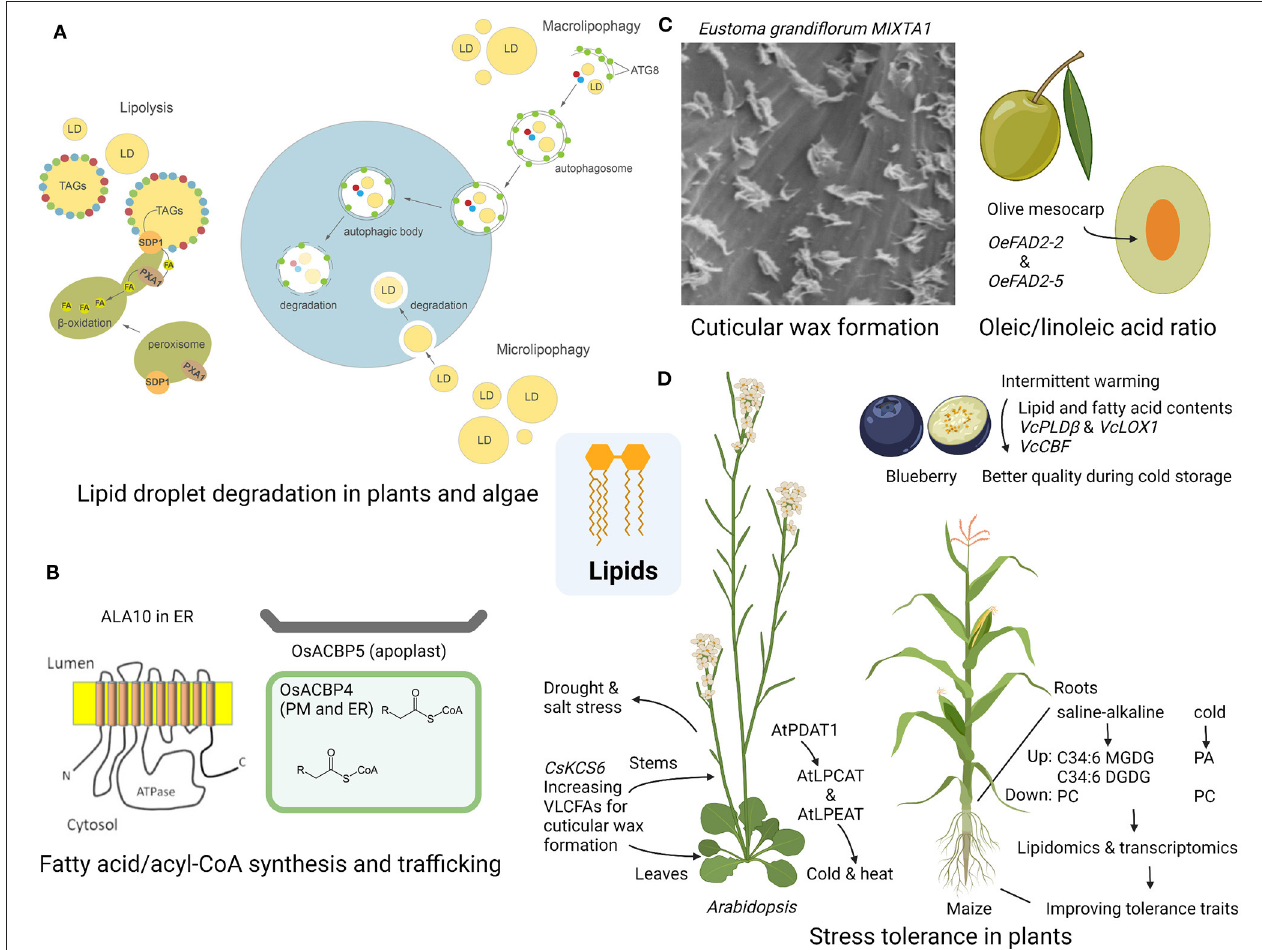
FIGURE 1 | Overview of the articles in this Research Topic. (A) Lipid droplet degradation in plants and algae (Zienkiewicz and Zienkiewicz). (B) Biosynthesis and trafficking of fatty acids ( Salvaing et al.) and acyl-CoAs (Liao et al.). (C) Lipid metabolism in cuticular wax formation in Eustoma grandiflorum (Wang et al.) and fatty acid composition in olive mesocarps (Hernández et al.). (D) Understanding the lipid and fatty acid dynamics in different plants including Arabidopsis under drought-salt ( Guo et al.) and cold stress (Demski et al.), blueberry fruit during cold storage (Dai et al.), and maize under saline-alkaline (Xu et al.) or cold stress (Zhao et